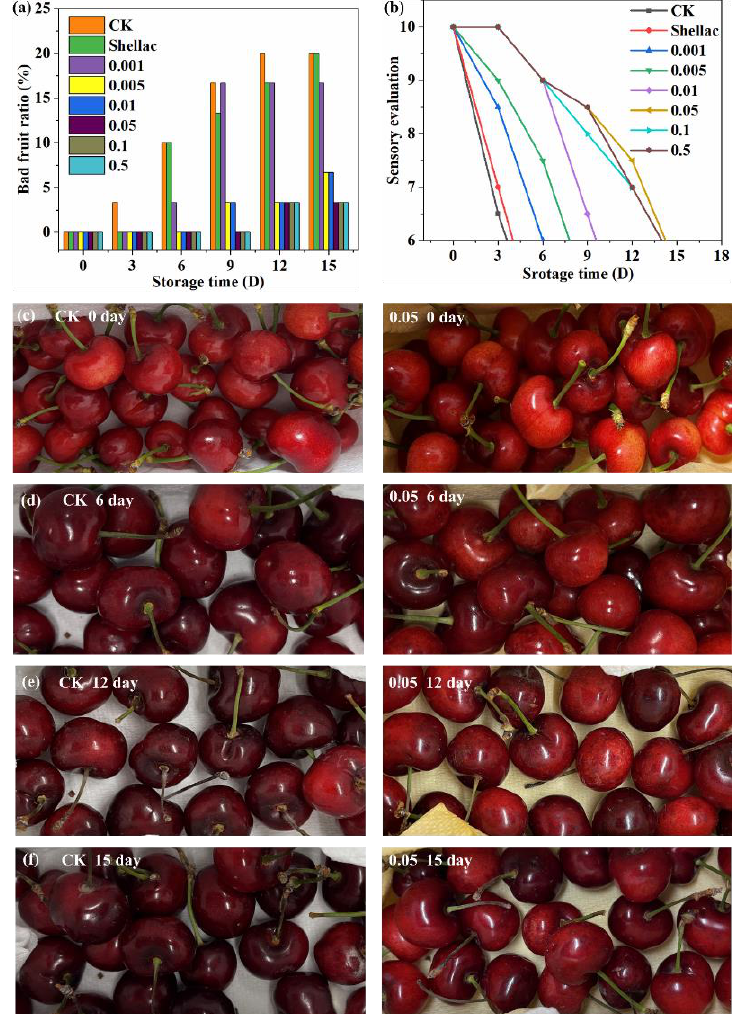
Figure 7. Bad-fruit ratio ( a ), sensory evaluation ( b ), comparison of the fresh-keeping effect of cherries with different 1-MCP additions ( c – f ), left 0 g, right 0.05 g. Table 2. Cherry sensory evaluation results.